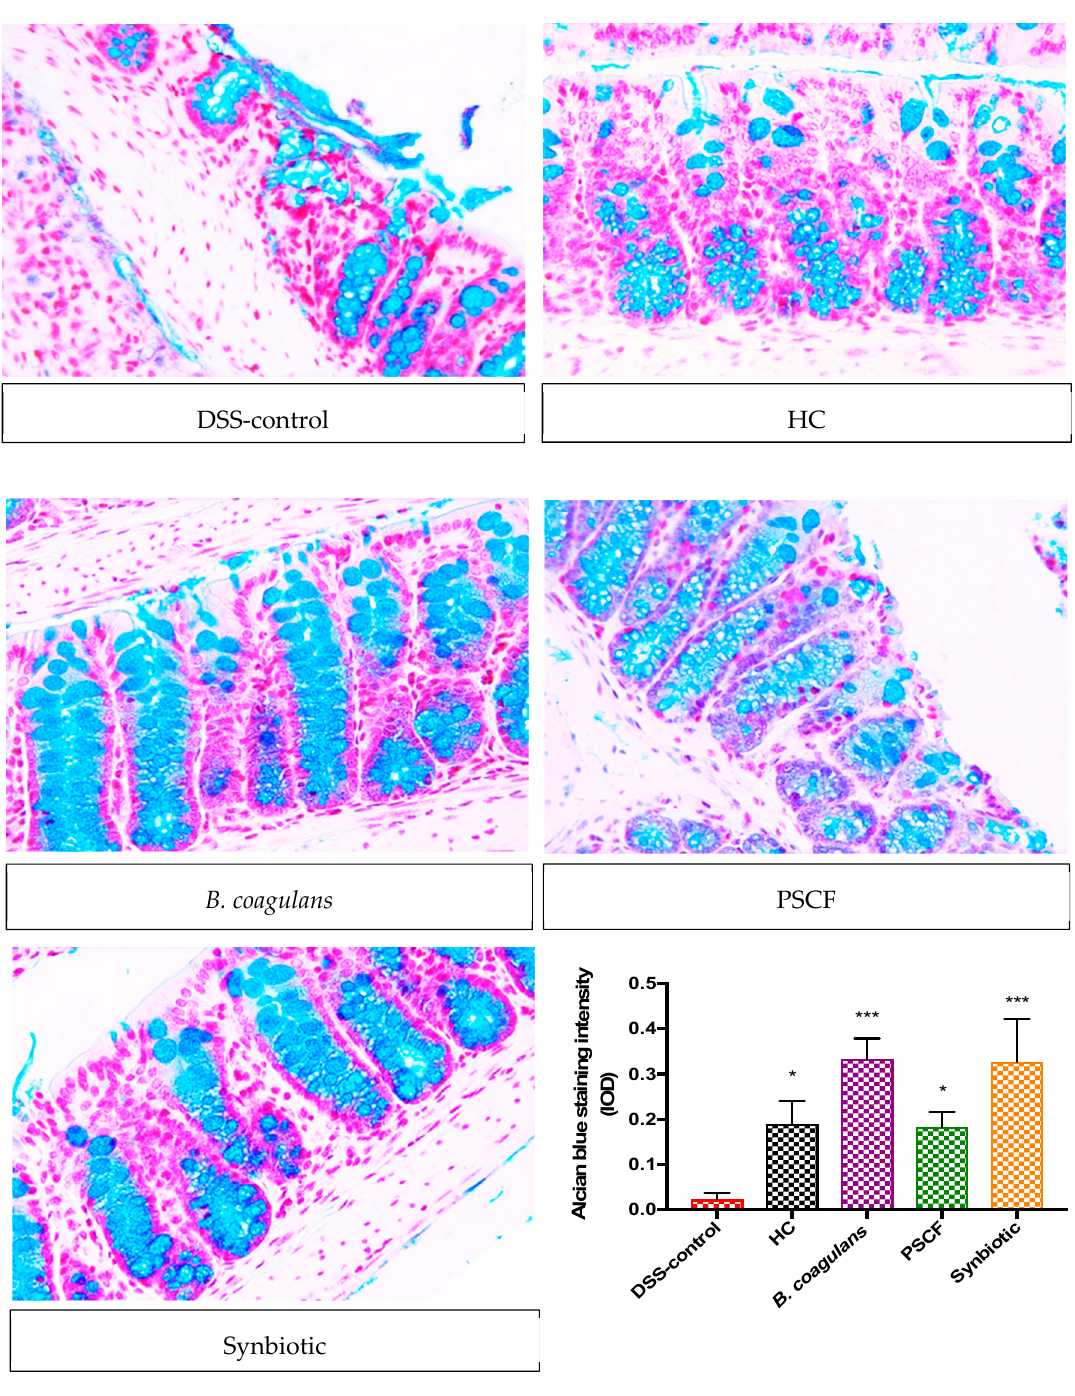
Figure 3. Effect of B. coagulans spores, PSCF and synbiotic on goblet cells. The paraffin embedded sections were stained with Alcian Blue to detect changes in goblet cells and in production of mucus in distal colonic tissue in each experimental group (40 × ) and staining intensity (IOD) of respective group is illustrated in the graph. Results expressed as mean ± SEM ( n = 4 per group), evaluated by one-way ANOVA followed by Tukey’s test (* p < 0.05, *** p < 0.001).